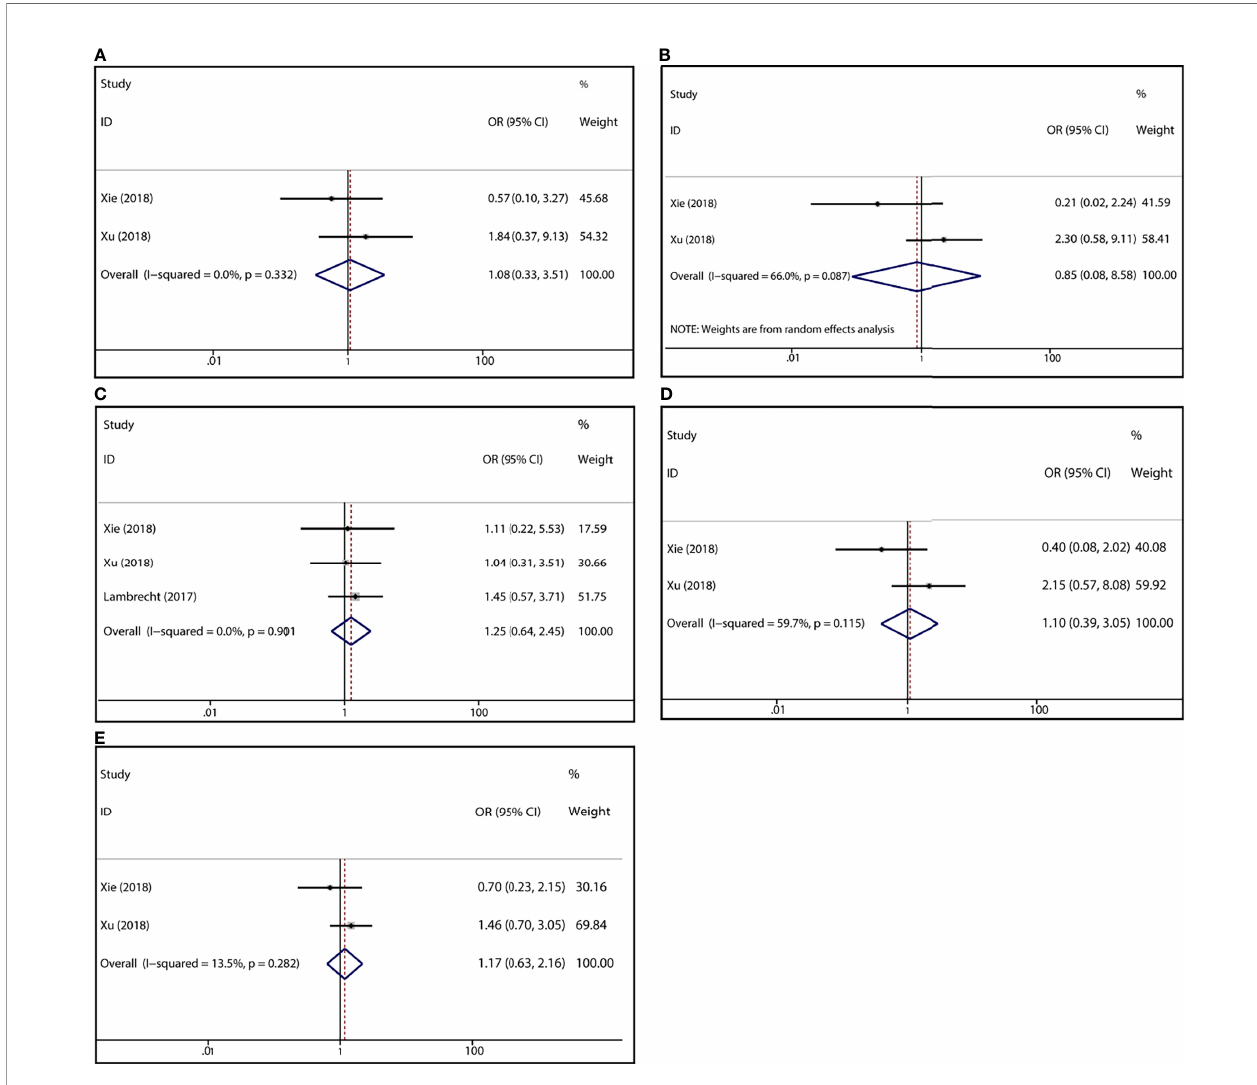
FIGURE 5 | Forest plots for the association between MTX-induced Anemia and MTHFR rs1801133 polymorphism. (A) homozygote comparison TT vs. CC; (B) heterozygote comparison TC vs. CC; (C) recessive genetic model TT vs. TC/CC; (D) dominant genetic model TT/TC vs. CC; (E) allele contrast T vs.